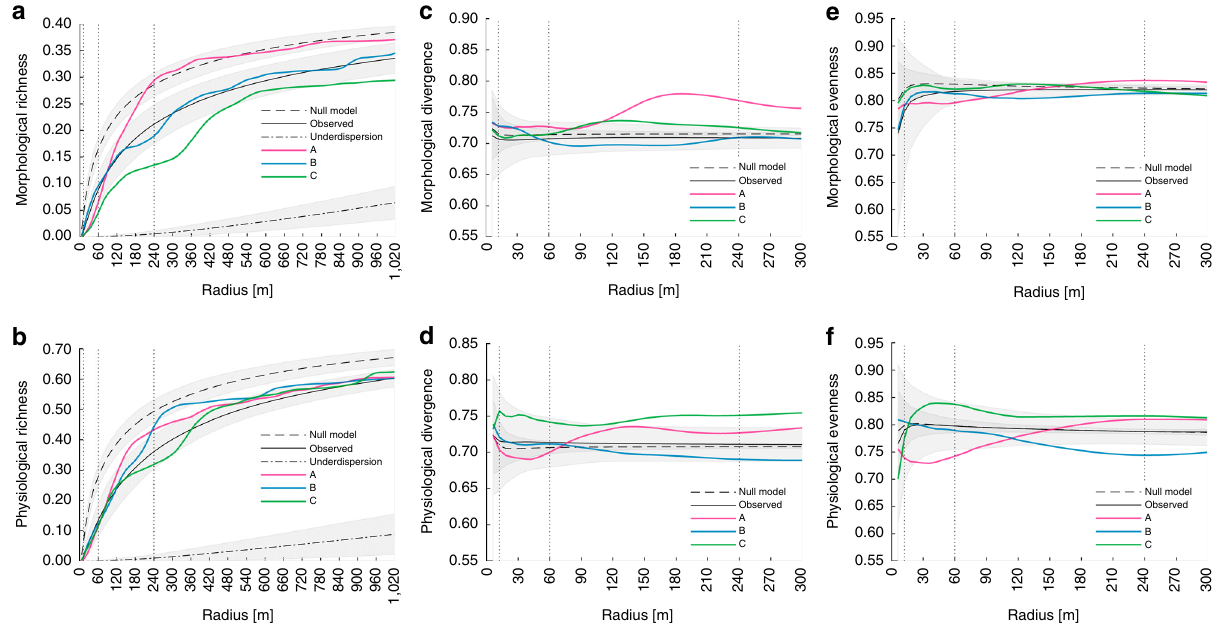
Fig. 8 Scale dependency of the three functional diversity measures for morphological and physiological traits. Functional a , b richness, c , d divergence and e , f evenness are displayed as a function of radius (diversity – area) for a , c , e morphological and b , d , f physiological traits. Null model corresponds to randomly distributed traits as dashed line. Observed corresponds to remotely sensed data as solid line. Underdispersion assuming direct neighbours corresponds to dashed – dotted line. Curves A, B C are stemming from a single pixel in the centre of subregions as in Fig. 5. Vertical dotted lines correspond to radii as in Fig.